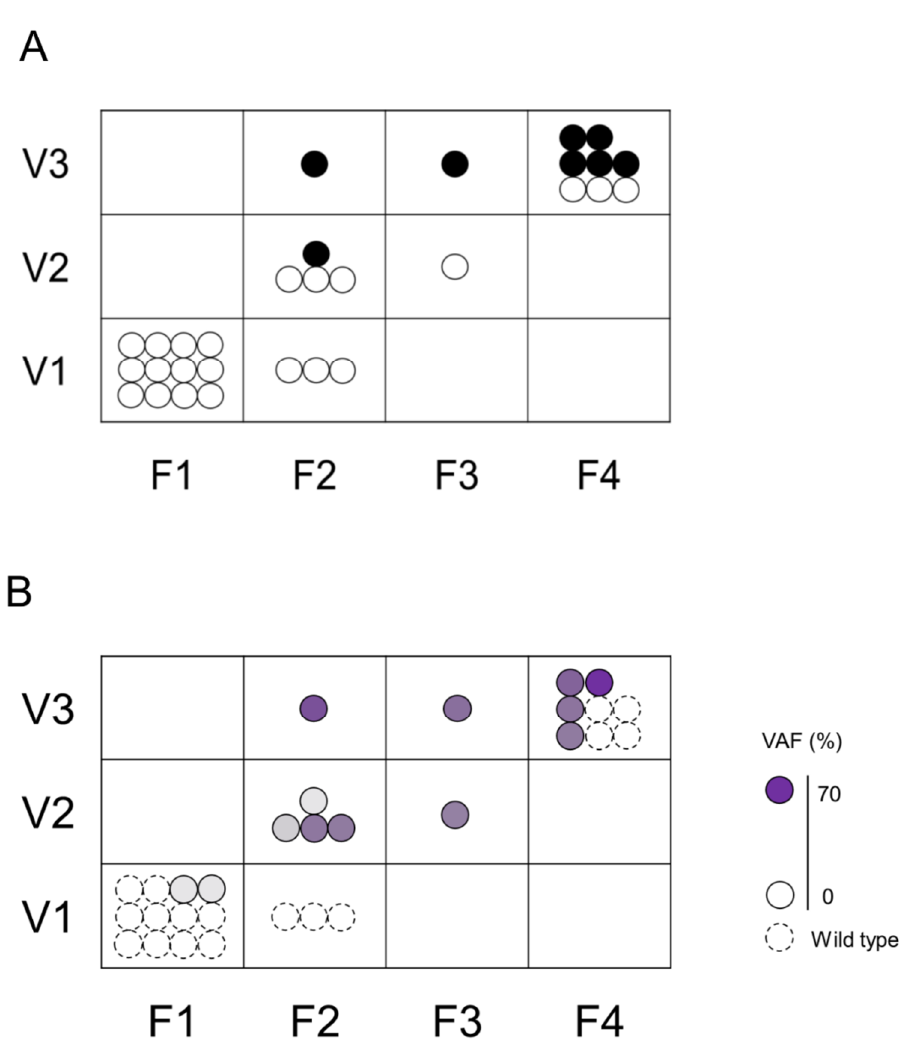
Figure 3. Association between the histological assessment and genetic mutations in F–V classification. The upper Figure ( A ) shows the association between F–V classification and histological assessment. Black circle (●) indicates malignancy and white circle ( 〇 ) indicates non-malignant lesions. The lower Figure ( B ) shows the association between F–V classification and genetic mutation. Dotted circles represent specimens without genetic mutation, and solid circles represent specimens with genetic mutation. The color density in the circle indicates the VAF.